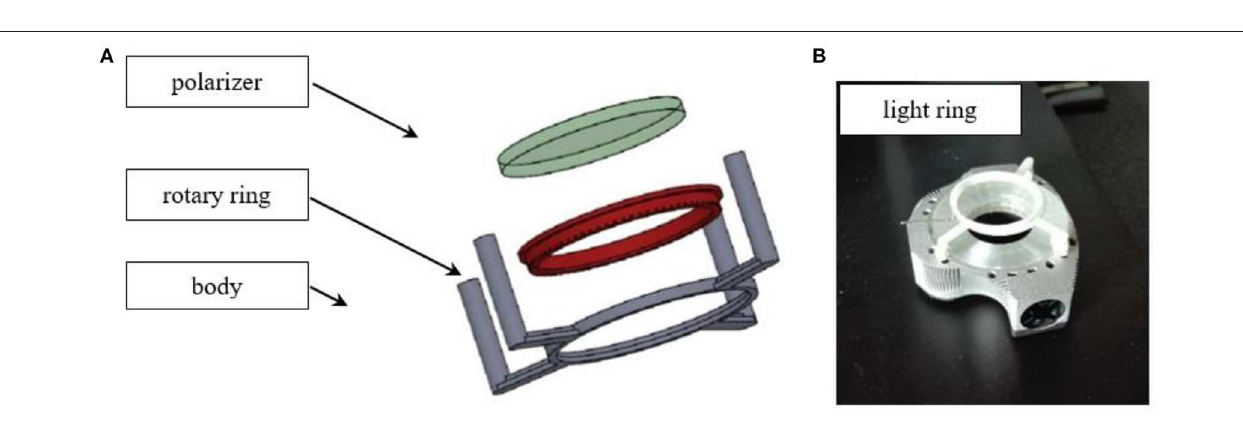
Frontiers in Mechanical Engineering |